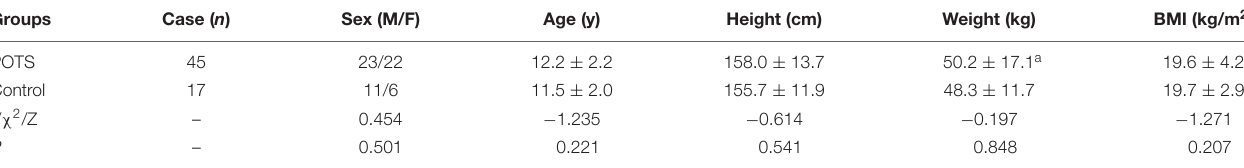
TABLE 1 | Demographic characteristics of children with postural tachycardia syndrome (POTS) and control groups.